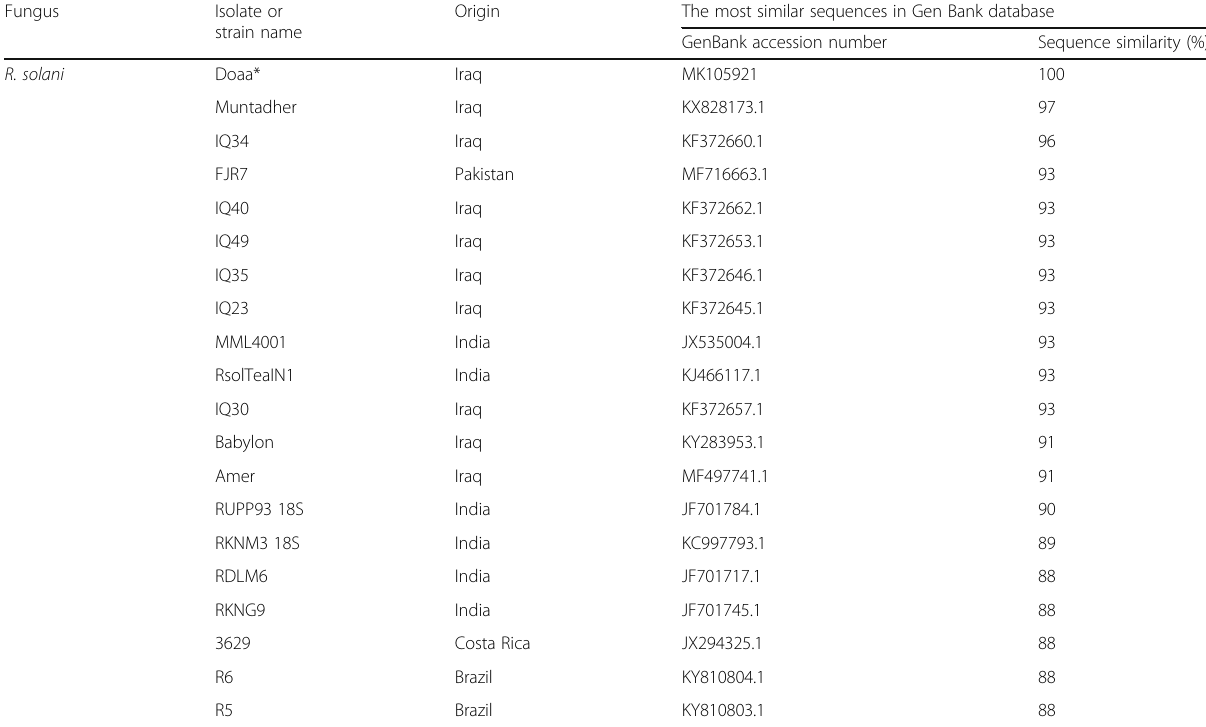
Table 2 Comparison of the similarity percentages of R. solani isolated from diseased cucumber plants, with the other isolates of the same fungus previously registered in GenBank Fungus Isolate or Origin The most similar sequences in Gen Bank database strain name GenBank accession number Sequence similarity (%) R. solani